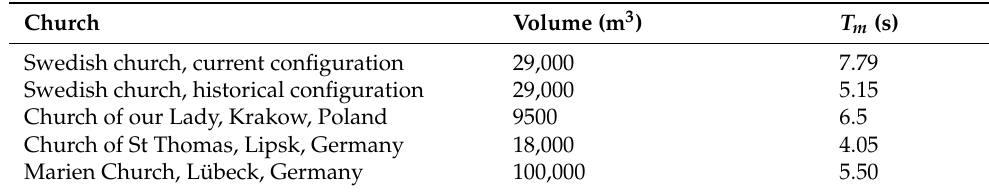
Table 2. Mid-frequency reverberation times for some Gothic churches in Northern